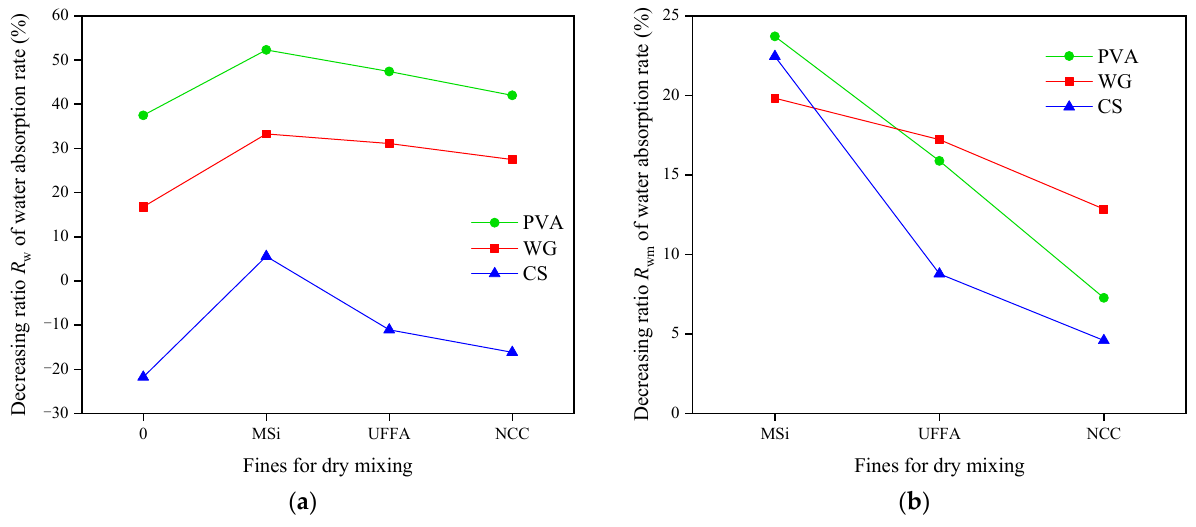
Figure 3. Relationship between the decreasing ratio ( a ) R w and ( b ) R wm of water-absorption rate with fines used for dry mixing when slurry coating with three kinds of solution.